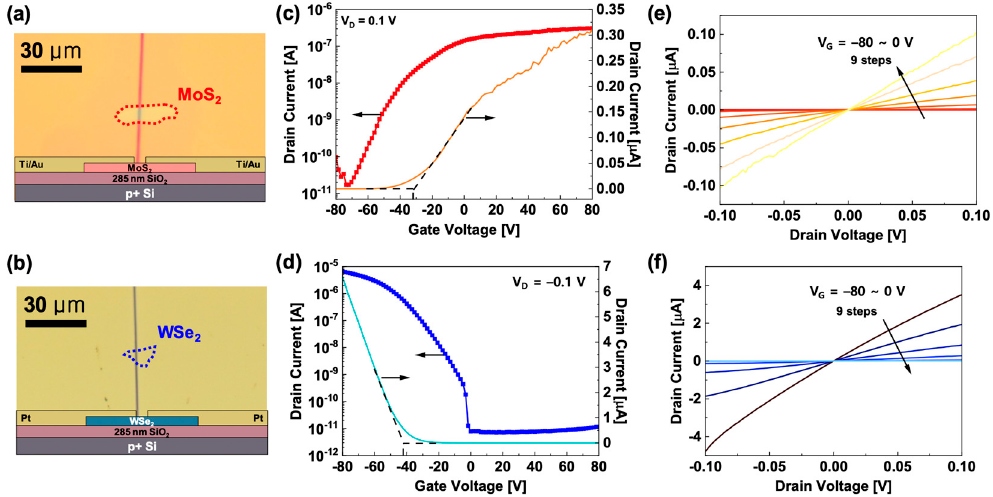
Figure 3. ( a , b ) Device schematic structures and OM images of the MoS 2 n-type metal-oxide- semiconductor (NMOS) and the WSe 2 PMOS; ( c , d ) Transfer characteristic curves of the MoS 2 NMOS and the WSe 2 PMOS; ( e , f ) Output characteristic curves of the MoS 2 NMOS and the WSe 2 PMOS, respectively.